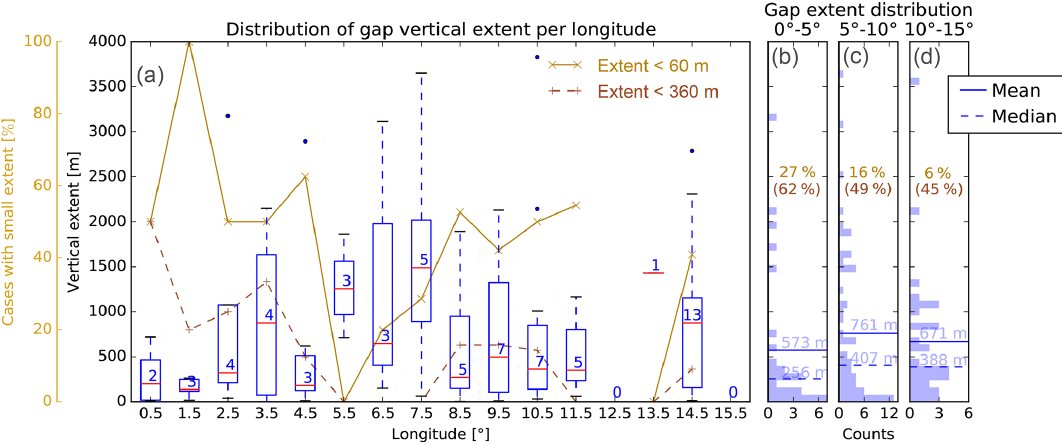
Figure 14. Distribution of vertical extent where the AOD does not change significantly with changing altitude (aerosol–cloud gap). (a) Box- and-whisker plot (red line representing mean of the bin, box representing the interquartile range, whiskers representing the minimum and maximum range, and outliers represented by dots, which are farther than 1.5 times the interquartile range from the first or third quartile) of the vertical extent binned by longitude. Numbers indicate the number of days sampled represented within each bin, where each sampled day constitutes more than one profile. The proportion of sampled days that are considered to have a small extent is denoted by the gold and brown colors. (b, c, d) The gap altitude distribution represented as a histogram for all sampled ACAOD from 4STAR for three separate longitudinal regions. The proportion of the gap extent that is near zero is indicated as a percentage in each panel (b, c, d) , the equivalent statistic for CEAL cases (within 360m) is below in